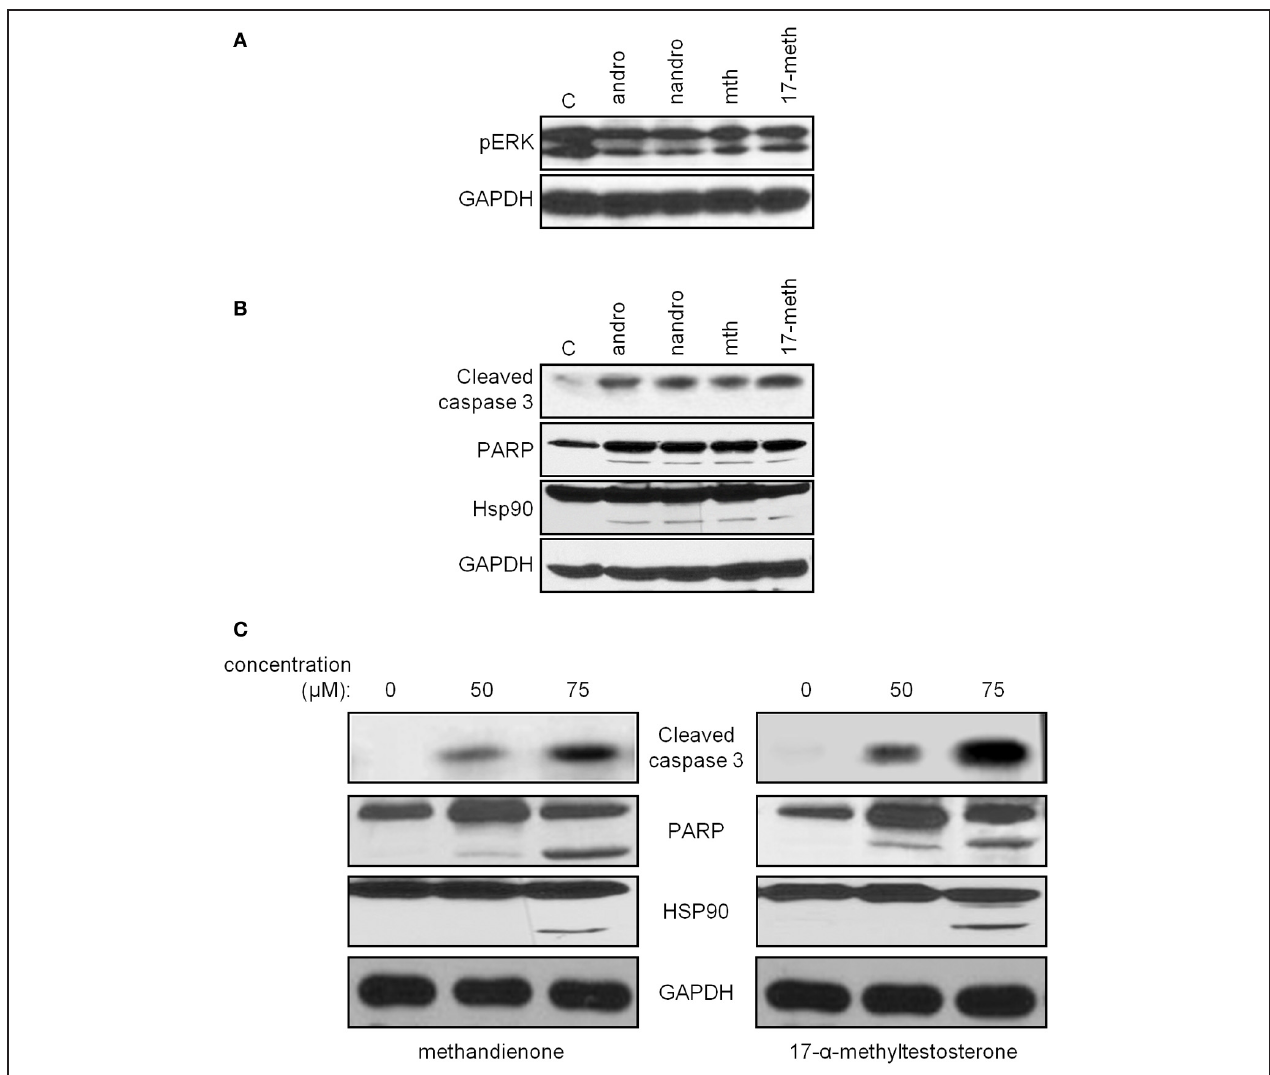
FIGURE 4 | Immunoblots demonstrate decreasing levels of phospho-ERK ( top panel ) in PC12 treated for 48h with 75 μ M androsterone, nandrolone, methandienone, and 17- α -methyltestosterone, compared to control treated cells (A). Immunoblots for caspase 3 ( top panel ), PARP ( second panel ), and Hsp90 ( third panel ) in PC12, control treated or treated 48h with 75 μ M androsterone, nandrolone, methandienone, and 17- α -methyltestosterone demonstrate increasing levels of the activated